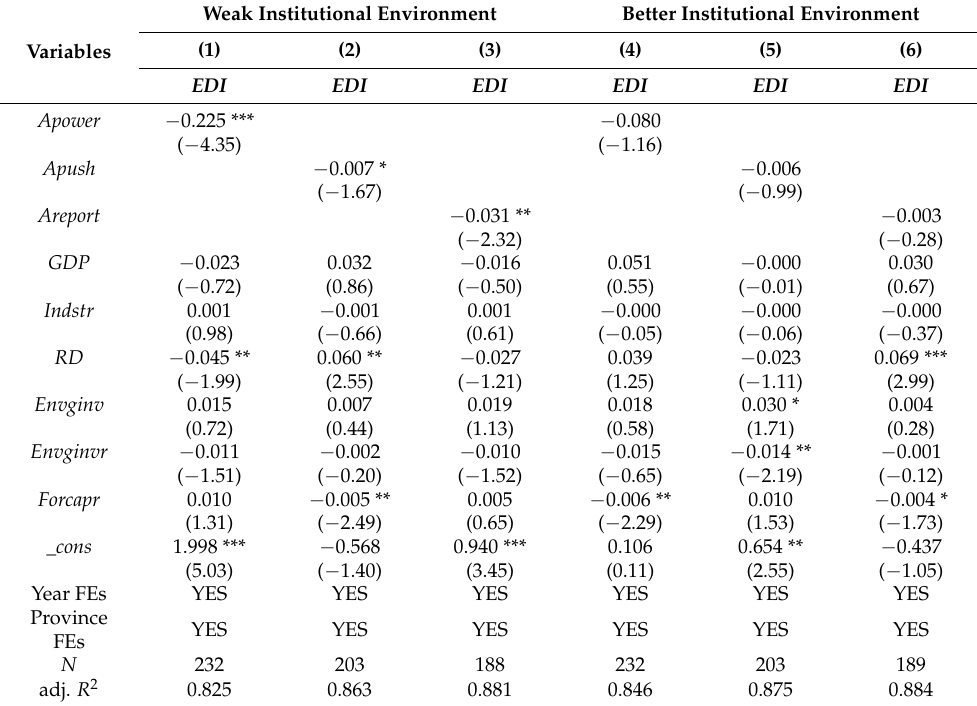
Table 8. Government auditing, institutional environment, and environmental quality.